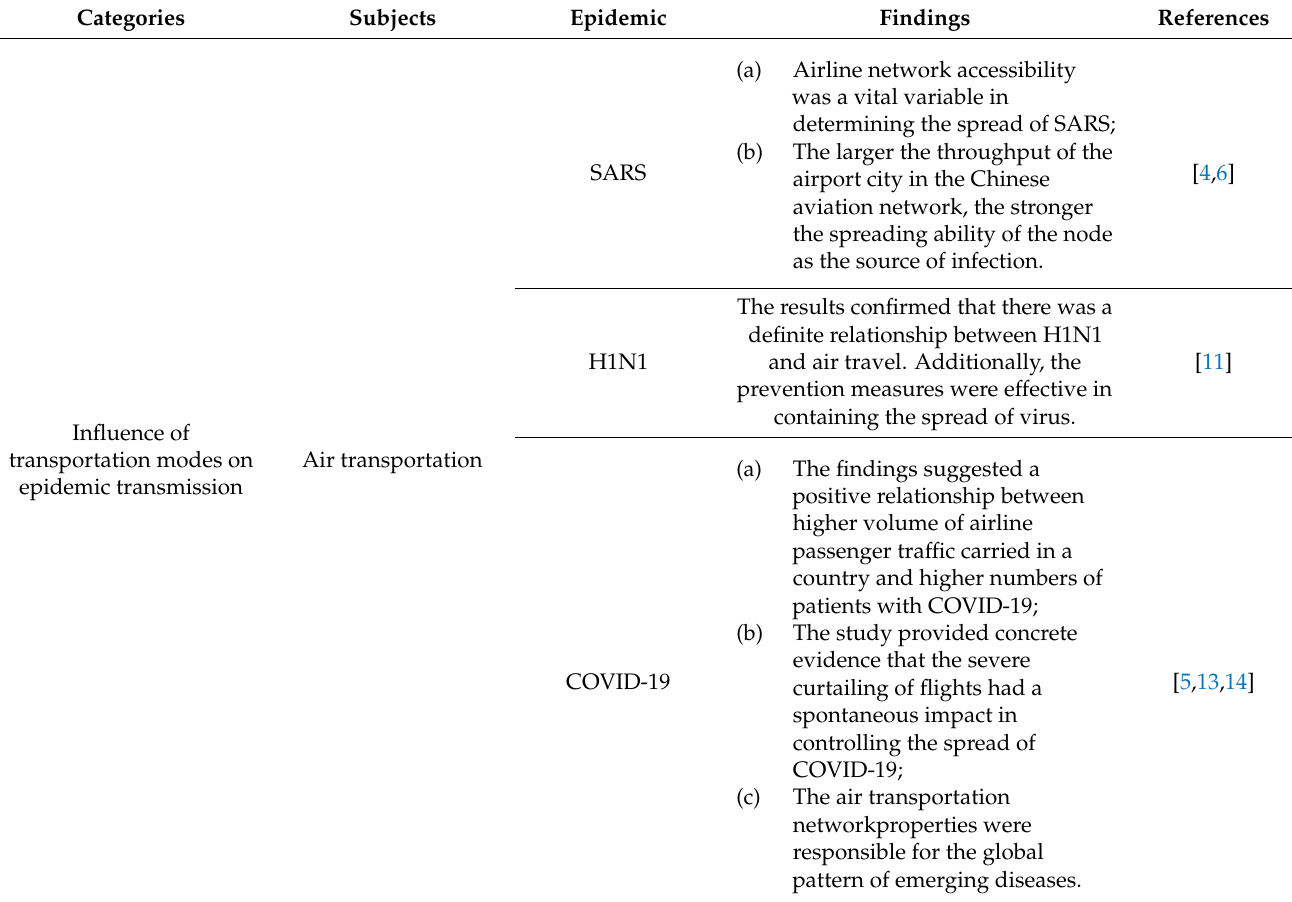
Table 1. Comprehensive papers on research